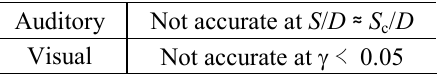
Summary of comparison among bubble sensor, auditory and visual.